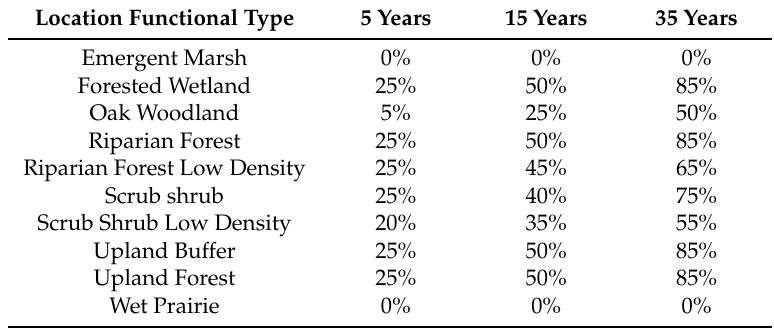
Table 2. Tree planting associated to functional type and increases in canopy cover (Washington County, OR,